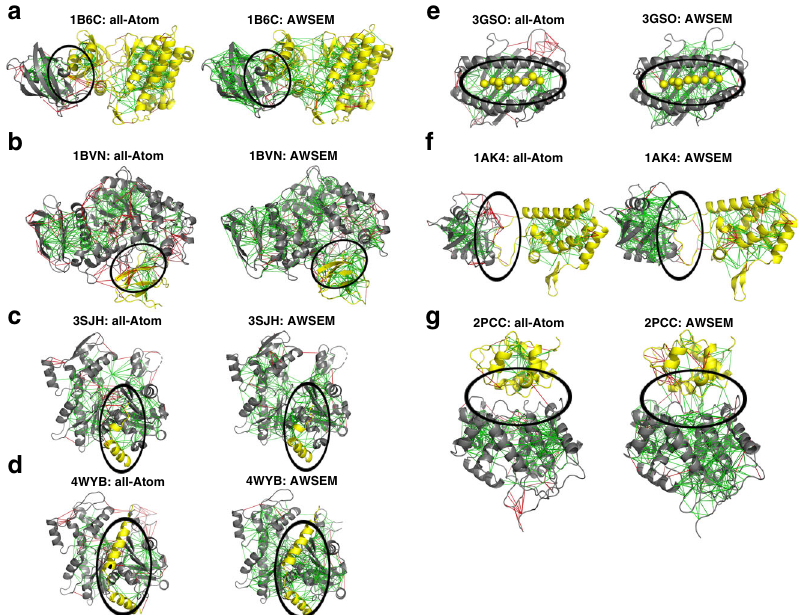
Fig. 4 Examples of localized frustration patterns in protein complexes. For each binding complex, the frustration indices are shown as calculated for the complex using both all-atom frustration (left panel) and coarse-grained frustration (right panel). Binding interfaces in ( a – e ) are largely dry interfaces dominated by non-water-mediated contacts, while the interfaces in ( f ) and ( g ) are rich in water-mediated contacts.